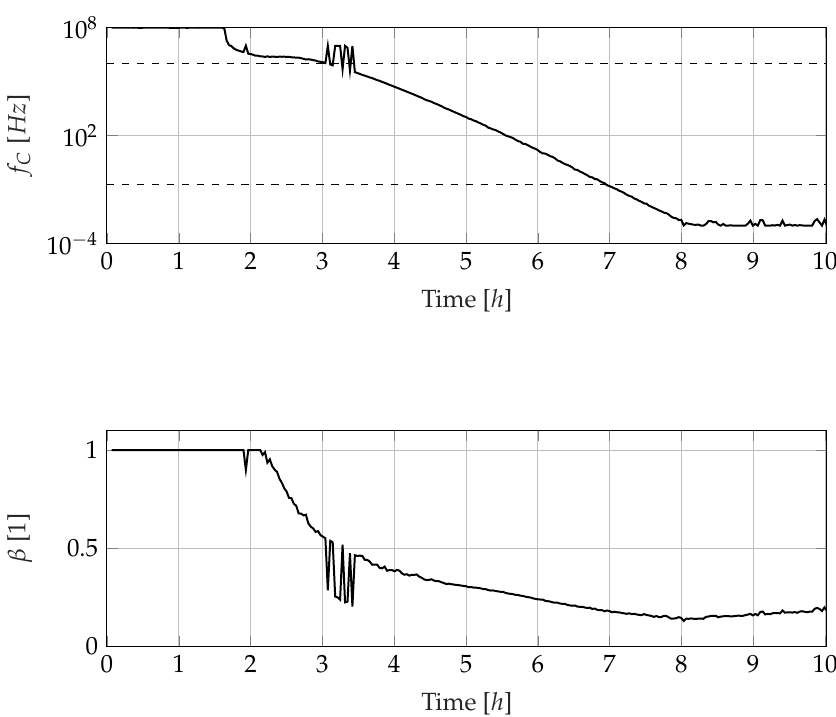
Figure 10. Course of the fitted parameters f C and β describing dipole relaxation.